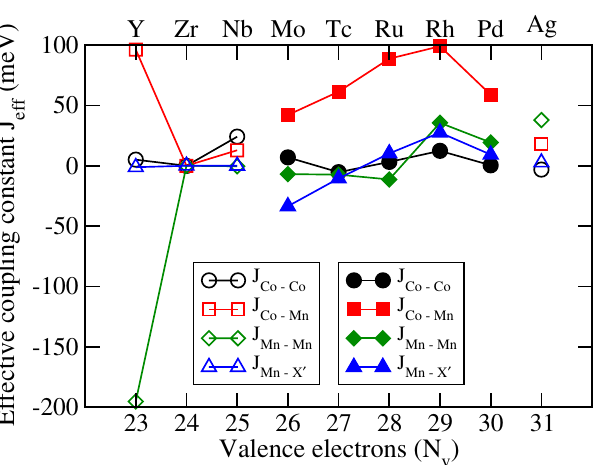
Figure 11. Calculated Curie temperatures with total number of valence electrons for CoX ′ Y ′ Si series.